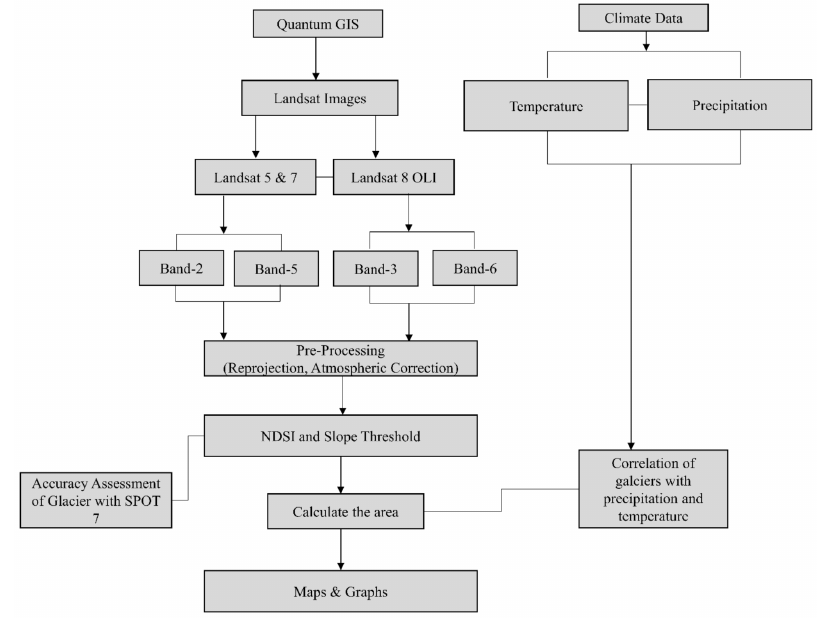
Figure 2. Flowchart of the